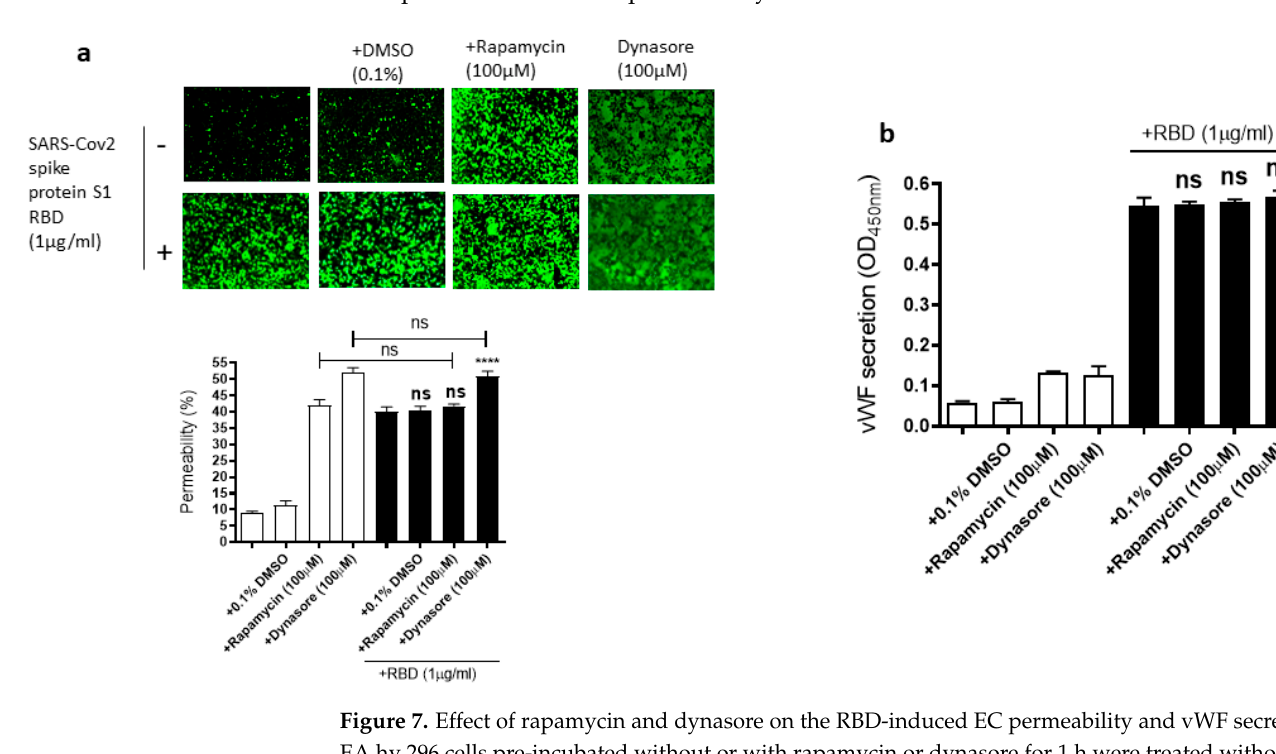
Figure 7. Effect of rapamycin and dynasore on the RBD-induced EC permeability and vWF secretion. EA.hy 296 cells pre-incubated without or with rapamycin or dynasore for 1 h were treated without or with 1 µ g/mL SARS-CoV-2 the spike protein S1 RBD for 72 h. ( a ) Visualization at 10 × magnification of the effect of rapamycin and dynasore on the RBD-induced EC permeability. ( lower panel ) Represents the quantification data of ( a ). ( b ) The effect of rapamycin and dynasore on the RBD-induced vWF secretion from EA.hy 296 cells. Statistical significance was measured by one-way ANOVA comparing the RBD-treated group with the control RBD-untreated group (**** p < 0.0001. ns, not significant).